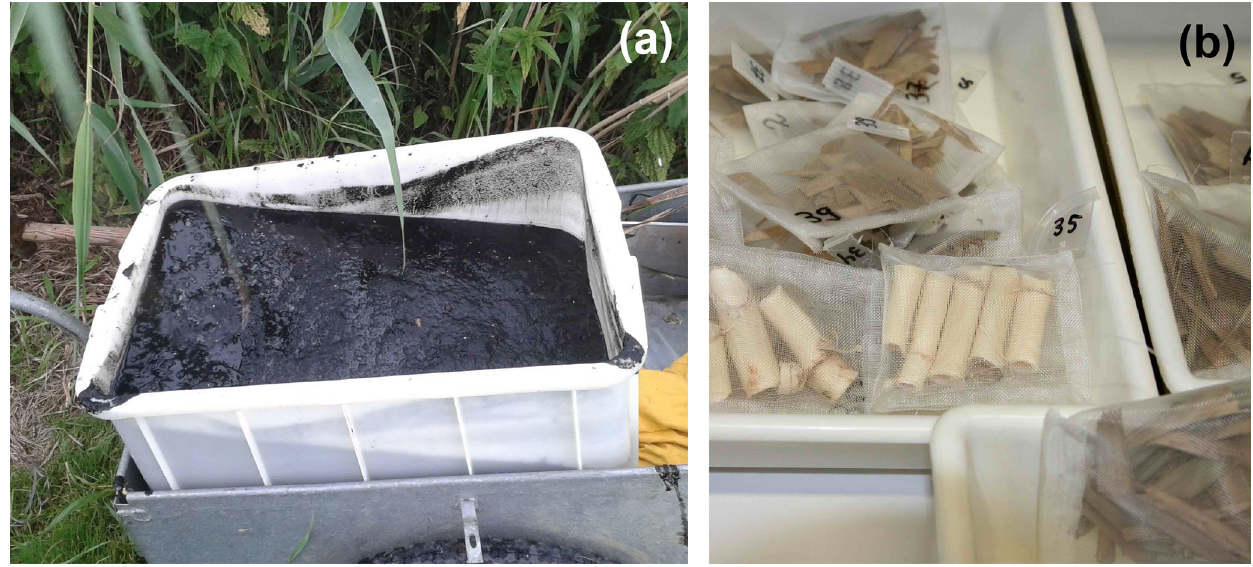
Figure 2. (a) The container with the detritus mud (high-N organic soil) from the rewetted Stangenhagen fen. Litterbags were placed in the containers in the anoxic zone of the substrate close to the bottom. (b) Litterbags with leaf and rhizome litter before